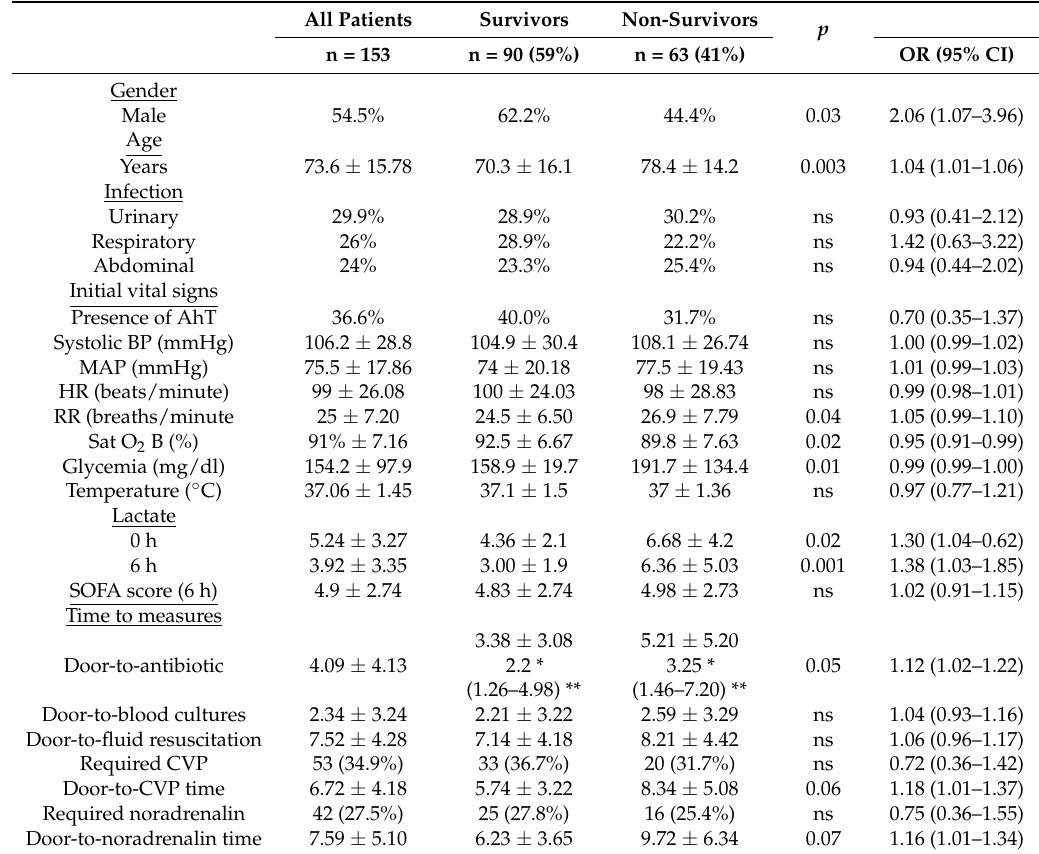
Table 1. Comparison, between the survivors and non-survivors, among patients who presented with severe community-acquired sepsis at the emergency